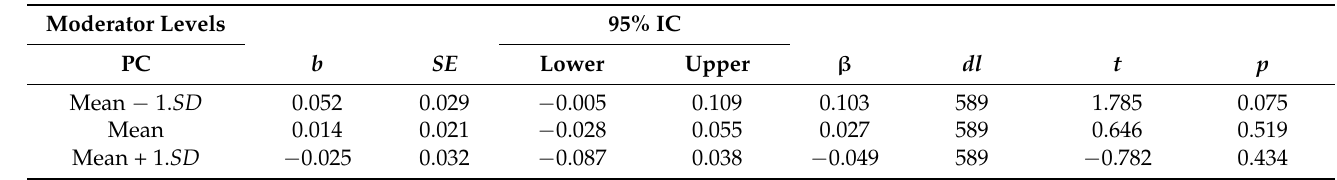
Table A2. Simple effects of GS attendance on prosocial behaviors at high, middle, and low perceived crowdedness of the place, when including both the main effect of covariates and two-way interac- tions between the covariates and the two moderators (i.e., perception of beauty and perception of